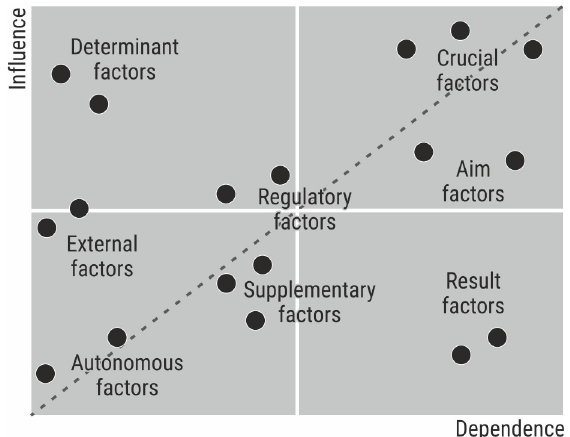
Fig 1. Arrangement of factors impacting the analysed research area. Source: [45,47].